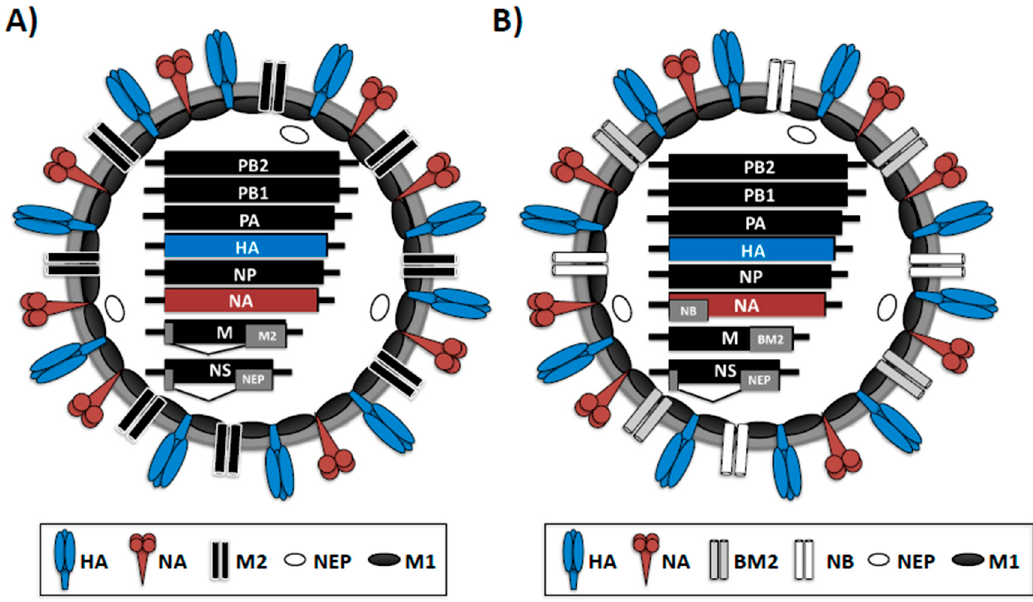
Figure 1. Virion structure of IAV ( A ) and IBV ( B ): IAV and IBV are surrounded by a lipid bilayer containing the two viral glycoproteins hemagglutinin (HA), responsible for binding to sialic acid-containing receptors in the surface of susceptible cells, and neuraminidase (NA), responsible for viral release from infected cells. Furthermore, in the virion membrane is the ion channel M2 (IAV) or BM2 and NB (IBV) proteins. Under the viral lipid bilayer is a protein layer composed of the M1 protein, which plays a role in virion assembly and budding, and the nuclear export protein (NEP) involved in the nuclear export of the viral ribonucleoprotein (vRNP) complexes. The eight viral segments and protein products are indicated inside the virions. Black lines at the end of each of the eight IAV and IBV vRNAs indicate the 3 ′ and 5 ′ non-coding regions (NCR). PB1 and PB2, polymerase basic 1 and 2; PA, polymerase acid; NP, nucleoprotein; NS, nonstructural gene; M: matrix; BM2: influenza B matrix protein 2.